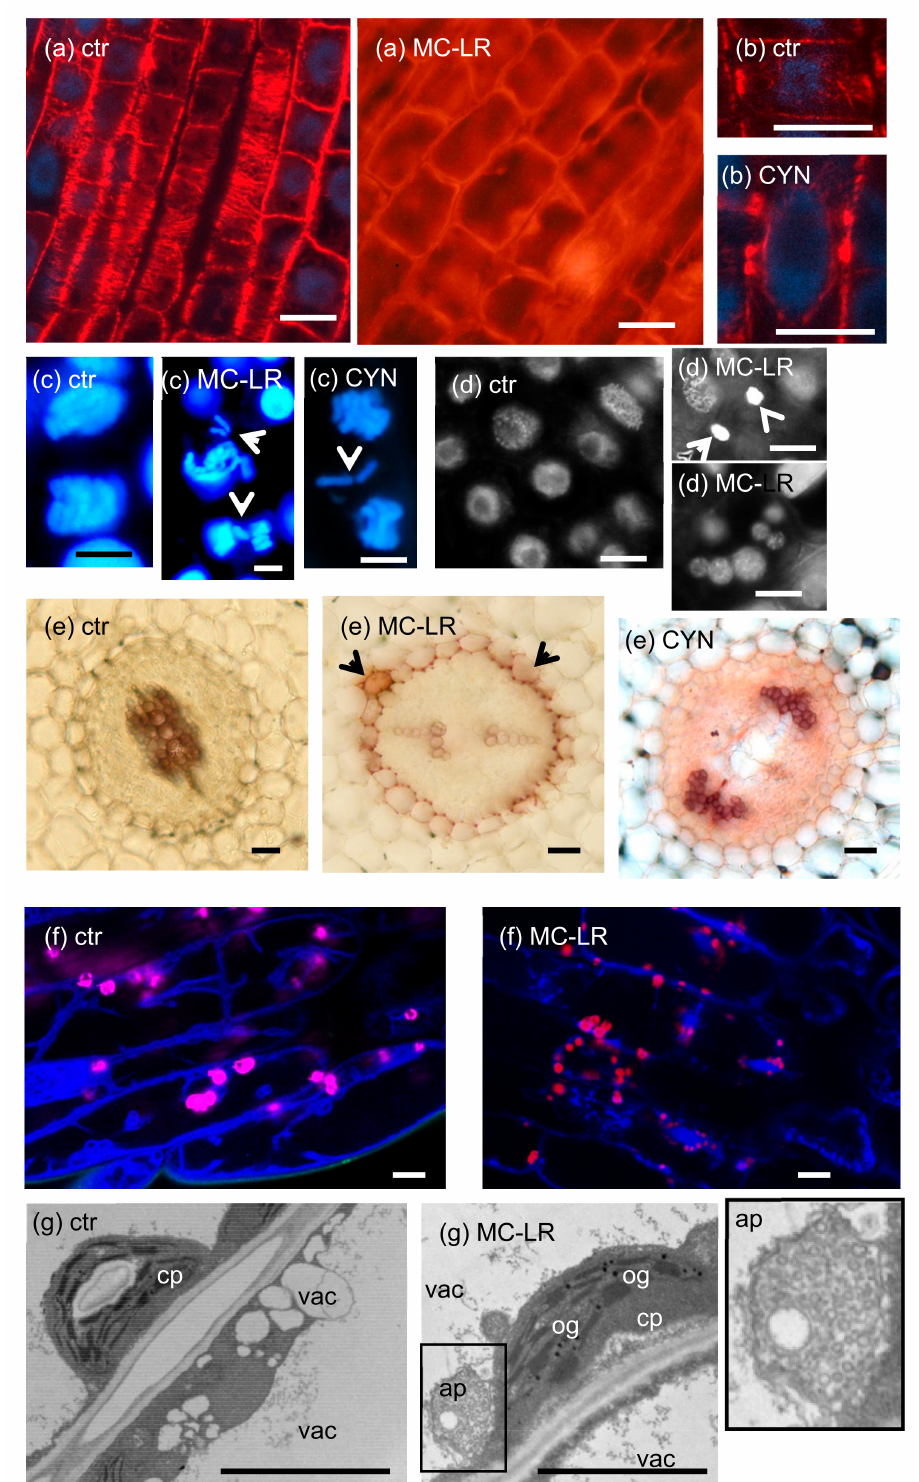
Figure 2. Characteristic subcellular alterations induced by MC-LR and CYN. Panels ( a – c ) etc. refer to distinct subcellular features; toxin treatments are presented alongside with controls (ctr). ( a ) Phragmites australis roots, control cells present normal cortical microtubules (CMTs), while two day-treatments with 20 µ M MC-LR induce depolymerization of CMTs and radial swelling of cells. ( b ) 10 µ M CYN induces the formation of double preprophase bands (PPBs) in P. australis roots. ( c ) Long-term treatments with high ( ≥ 5 µ M) concentrations of both MC-LR and CYN induce the formation of lagging